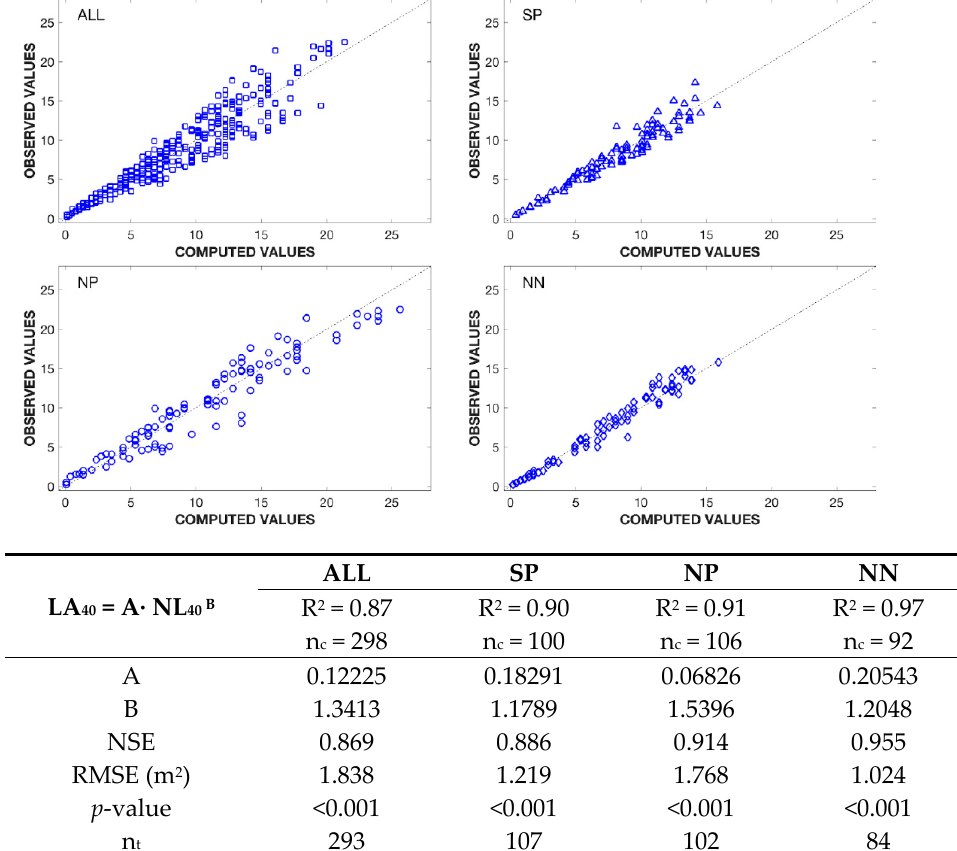
Figure 3. Performance of the regression model for estimating leaf area (LA 40 ) from those leaves with a central nerve length longer than 40 cm (NL 40 ). The model with coefficients A and B was fitted individually for each location studied (SP, NP, and NN), but also using all data of the three locations (ALL). The n c and n t indicate the number of data used for the model calibration and testing, respectively.